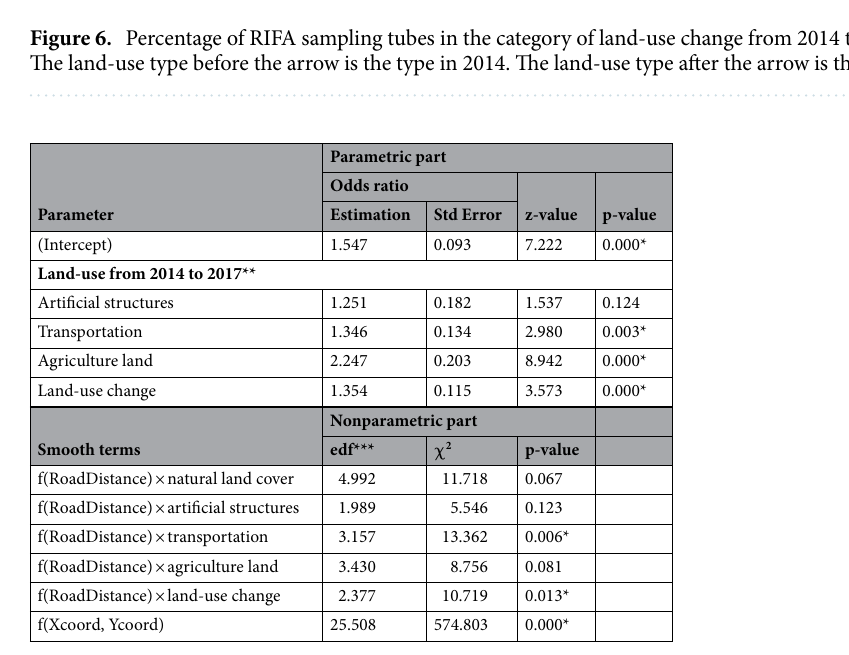
Table 2. GAM-2 regression model for RIFA successful invasion or remaining at the highest level of invasion in Kinman, Taiwan (N = 6,918). *Significant at α = 0.05. **Natural land cover as the reference category. ***Effective degree of